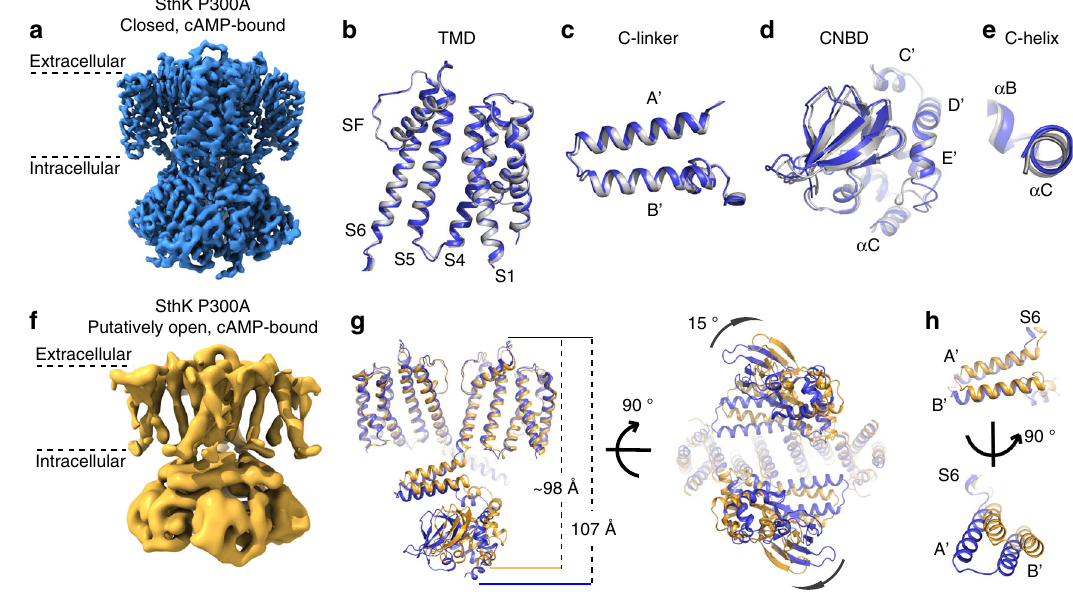
Fig. 4 Cryo-EM structures of SthK P300A. a Density map of SthK P300A bound to cAMP in the closed state. b – e Comparison of WT SthK (PDB: 6CJU, gray) and SthK P300A (blue) in the closed state. Both structures were aligned to the turrets of WT SthK. Comparison of the TM domains is shown in ( b ), helices A ′ and B ′ of the C-linker are in ( c ), the CNBDs in ( d ), and the C-helix in ( e ). f Density map of SthK P300A in the putatively active state. g , h Comparison between SthK P300A in the closed state (blue) and the putatively active state (yellow) with both structures aligned to the turrets of the closed state. g Side and bottom view of two subunits. h Helices A ′ and B ′ of the